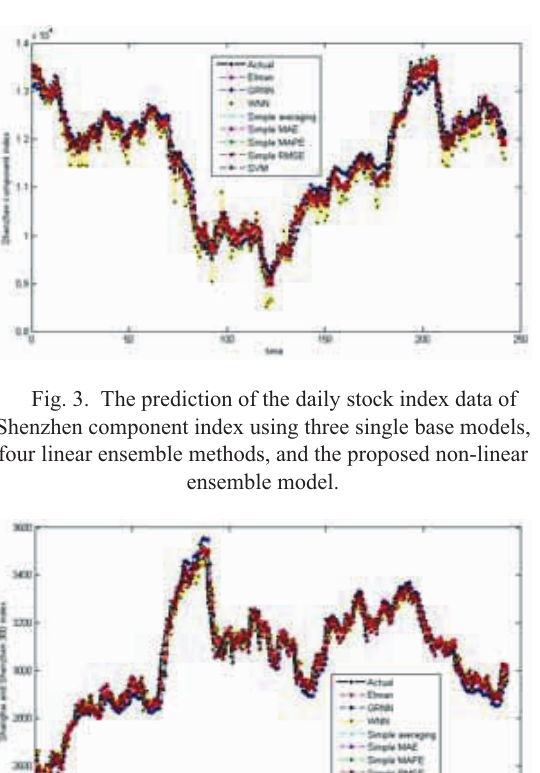
Fig. 2. The prediction of the daily stock index data of Shanghai composite index using three single base models, four linear ensemble methods, and the proposed non-linear ensemble model.